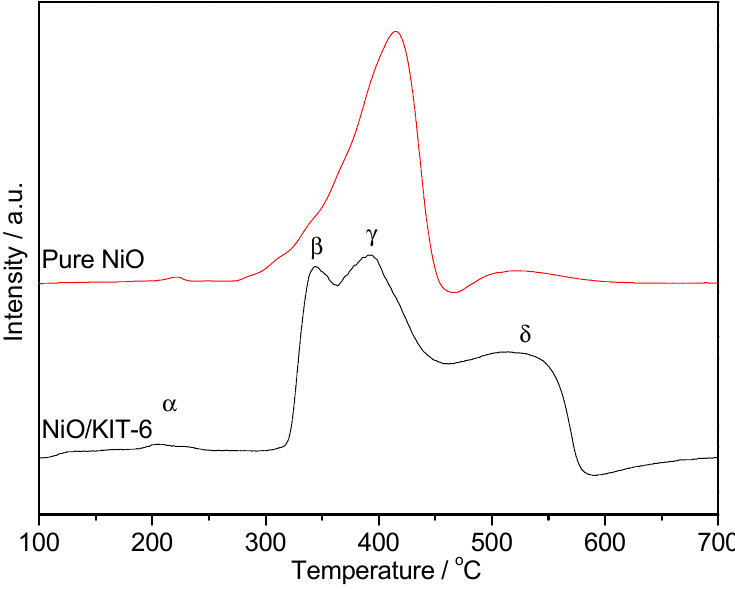
Figure 1. H 2 -TPR patterns of catalyst precursor and pure NiO.